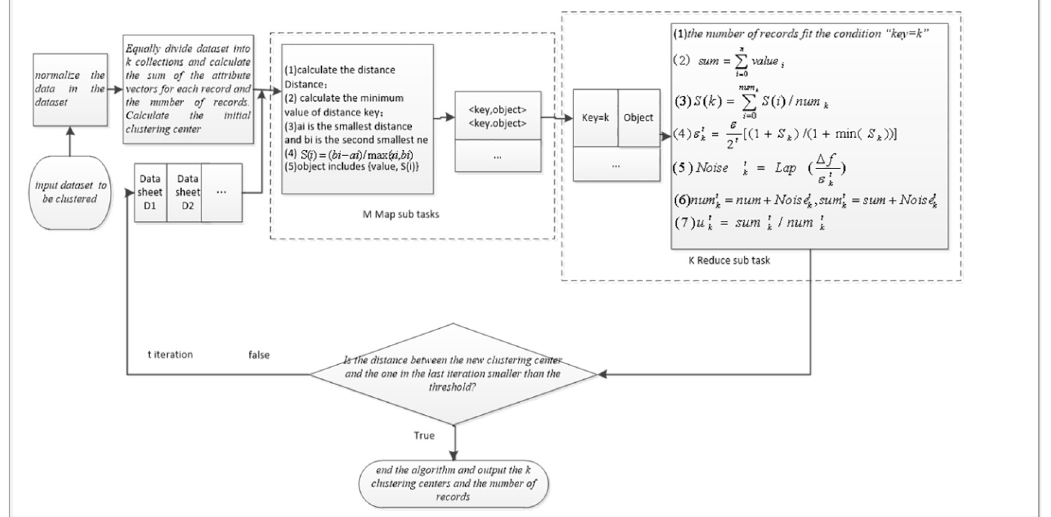
Fig 3. Flow chart of DPK-Means clustering algorithm based on contour